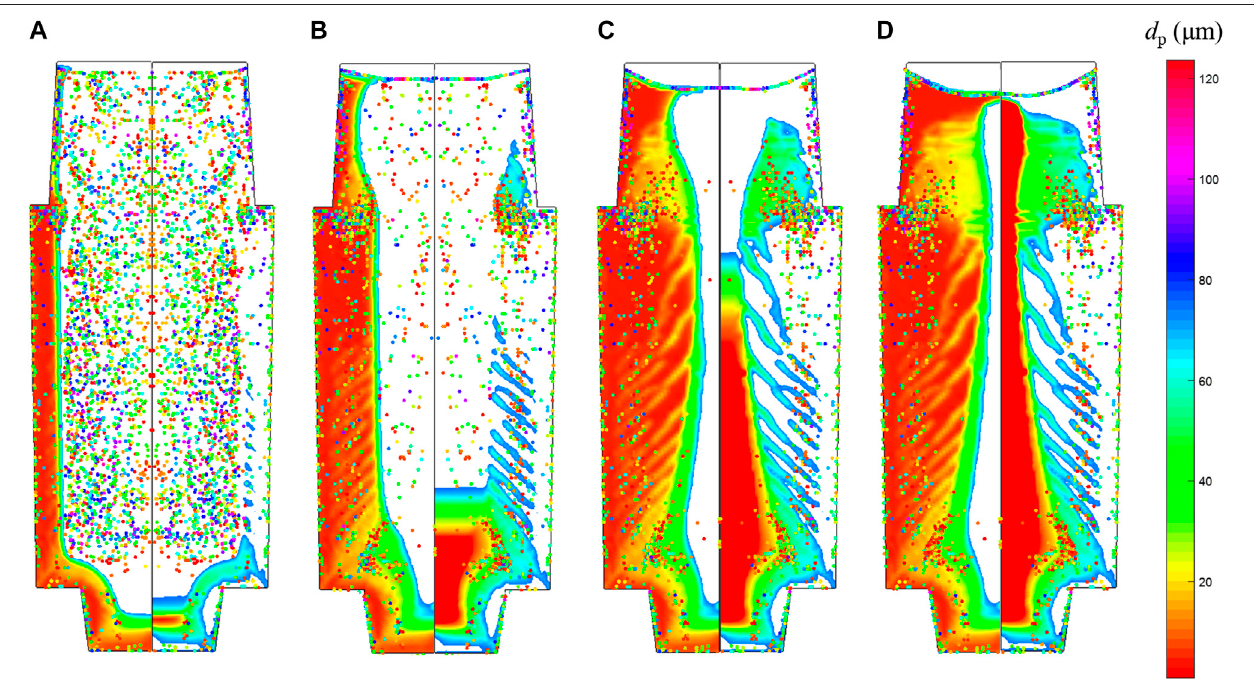
FIGURE8| Predictedinclusiondistributionandgrowingprocessofcolumnarandequiaxedcrystalsinthe36-toningotwiththe fi ve-phasemodelatdifferenttimes: (A) 0.5 h, (B) 2 h, (C) 5 h, (D) end of solidi fi cation. Inclusion particles are represented by colored dots with different diameters. The left half shows the columnar volume fraction, and the right half shows the equiaxed volume fraction.